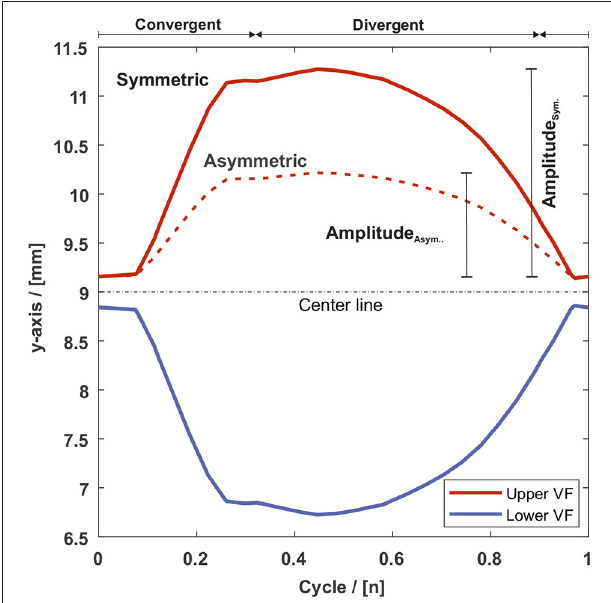
FIGURE 4 | Exemplary vocal fold motion of GC1 for the symmetric and asymmetric case along the y-axis (medial-lateral direction) for a point on the medial plane of the VF surface, see the red mark at GC1 in Figure 3 . The solid red line represents the motion on the y-axis of the upper vocal fold for the symmetric and the dashed line for the asymmetric motion. The blue line represents the motion on the y-axis of the lower vocal